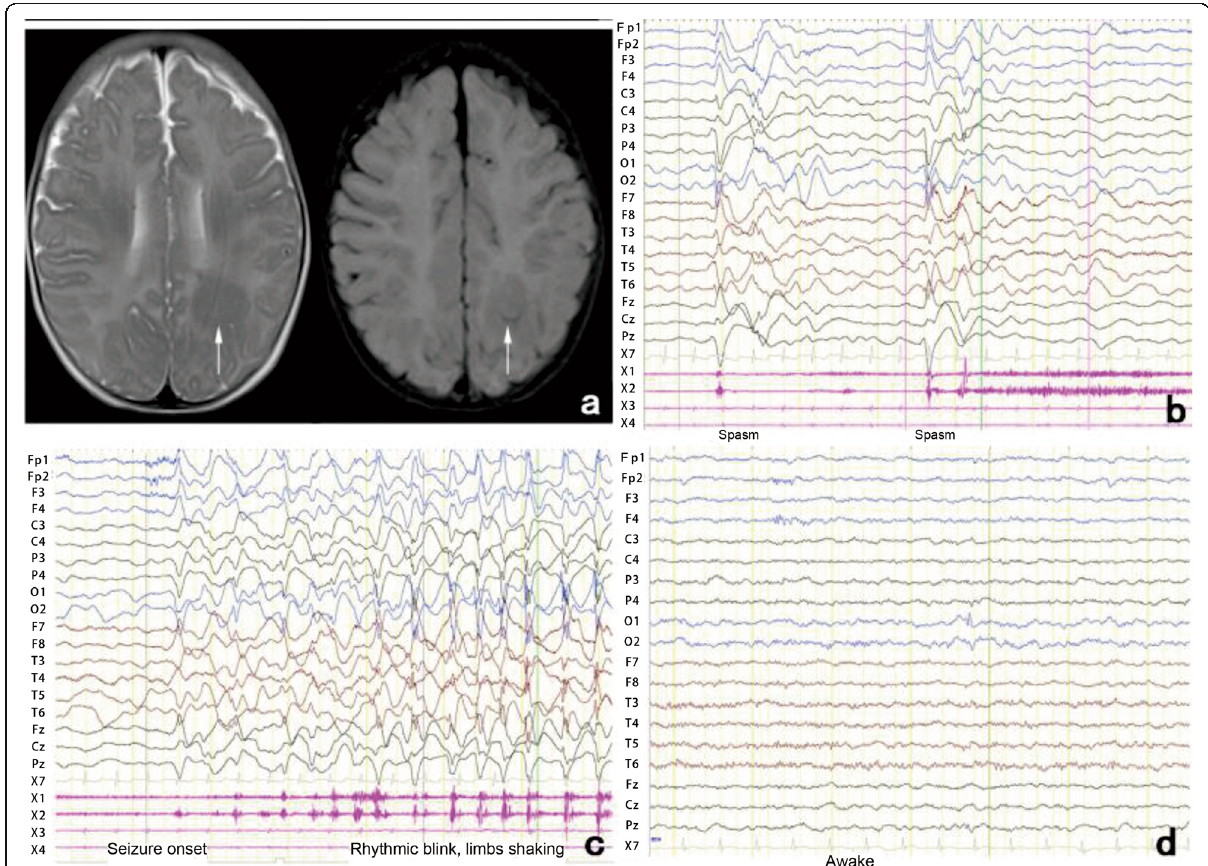
Fig. 1 MRI and video EEG in patient 1. a Cerebral MRI revealed an abnormal gray signal (arrows) in the semiovale located in the left parietal- occipital lobe of the patient. b – d Video EEG showed spasm attacks ( b ), and focal seizures starting in the left occipital region ( c ). Normal EEG activity recorded 1 year after surgical resection ( d